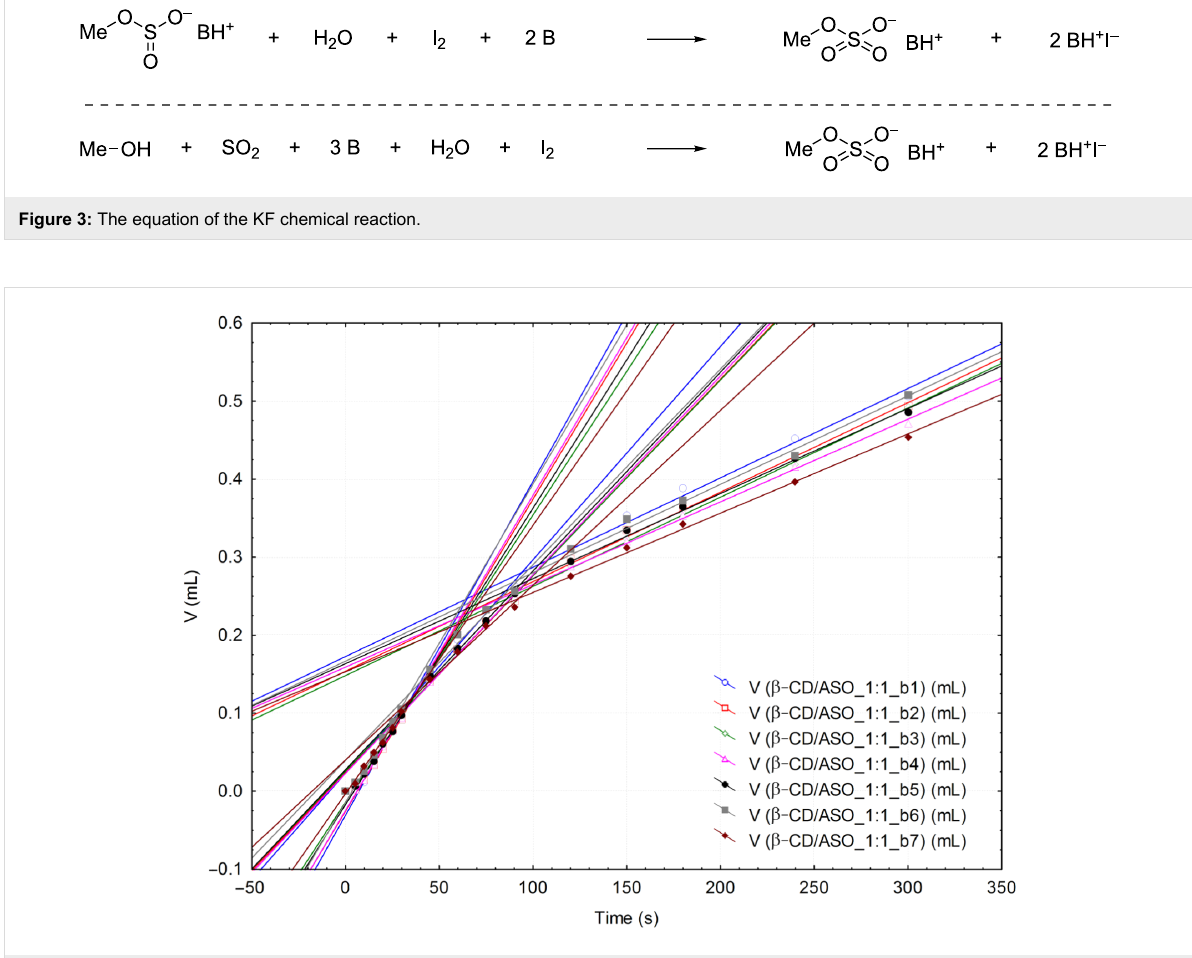
Figure 4: Superimposed volume versus time linear correlations (all three specific intervals) from the KFT analysis of β -CD/ASO_1:1 (only the second replicate “b” of the complex is presented; there are seven determinations).